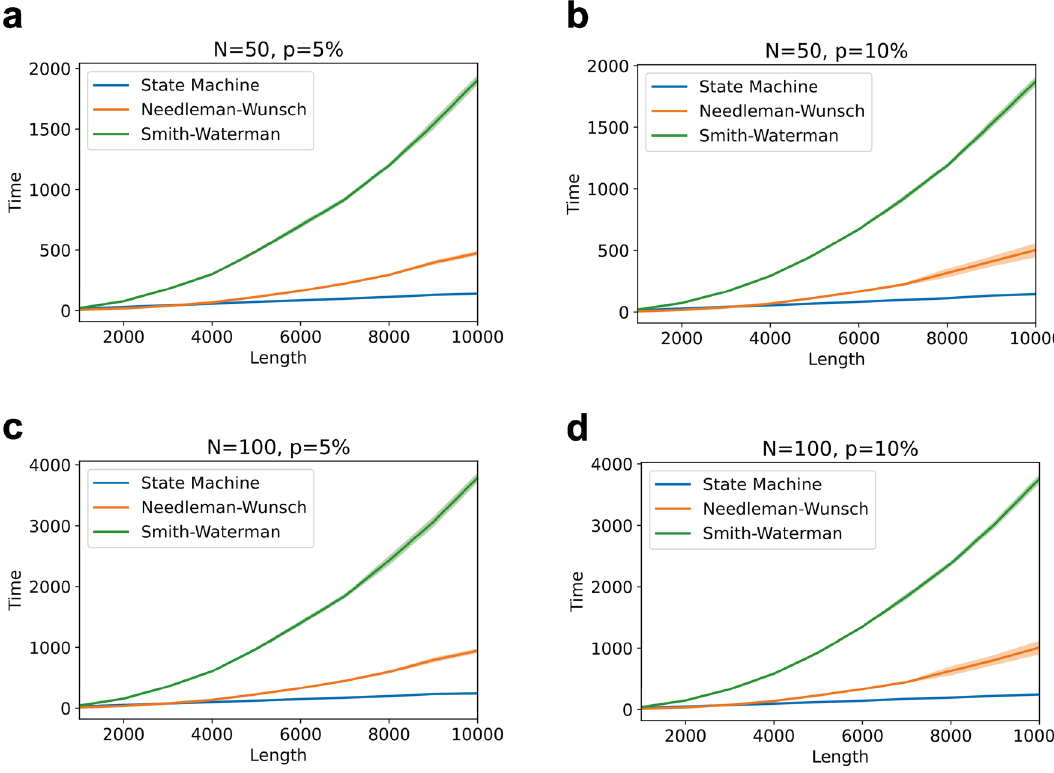
Figure 7. Time complexity analysis. We compare the running time of our mutation detection method and two common alignment algorithm through the synthetic experiments. We use 4 combinations of different number of sequences in each group N and mutation probability p : ( a ) N = 50, p = 5% ; ( b ) N = 50, p = 10% ; ( c ) N = 100, p = 5% ; ( d ) N = 100, p = 10% . The time complexity of our method is O ( N ) while the